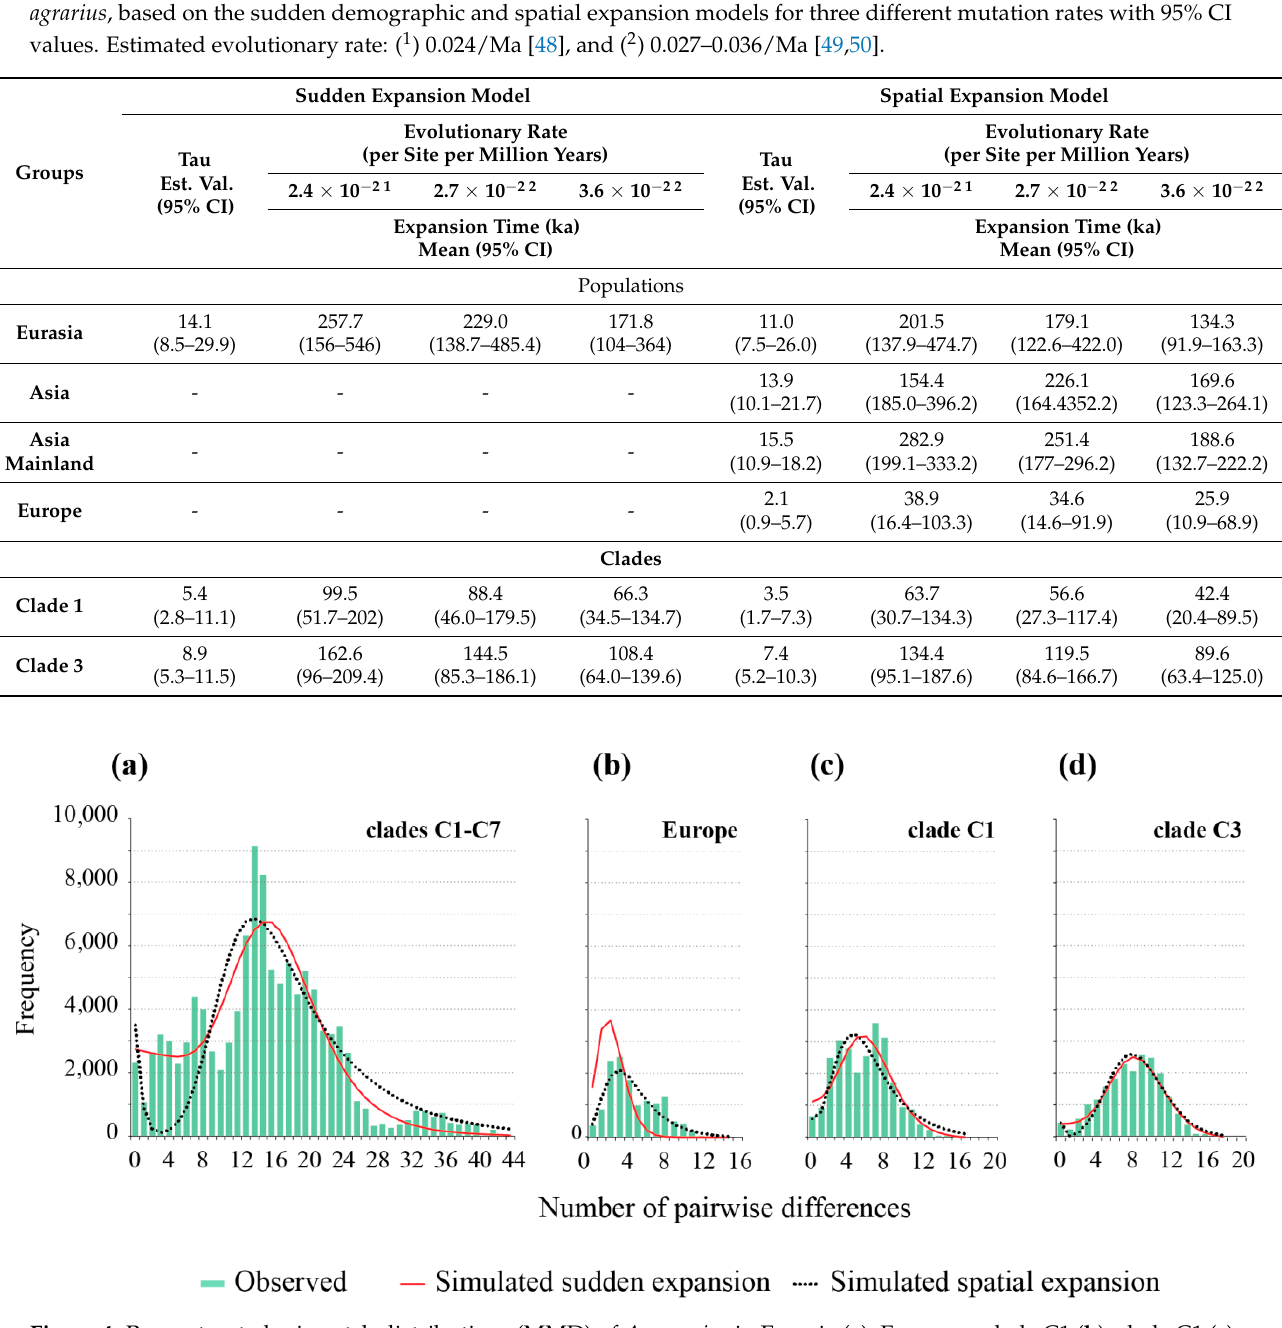
Figure 5. The reconstructed demographic history of A. agrarius obtained from the Bayesian skyline plot (BSP) in Eurasia ( a ), clade 1 ( b ), and clade 3 ( c ). Solid red lines—median, green areas—95% HPD confidence limits, violet lines—mean growth rates (with 95% HPD). The arrows indicate the estimated start of expansion based on the mismatch distribution